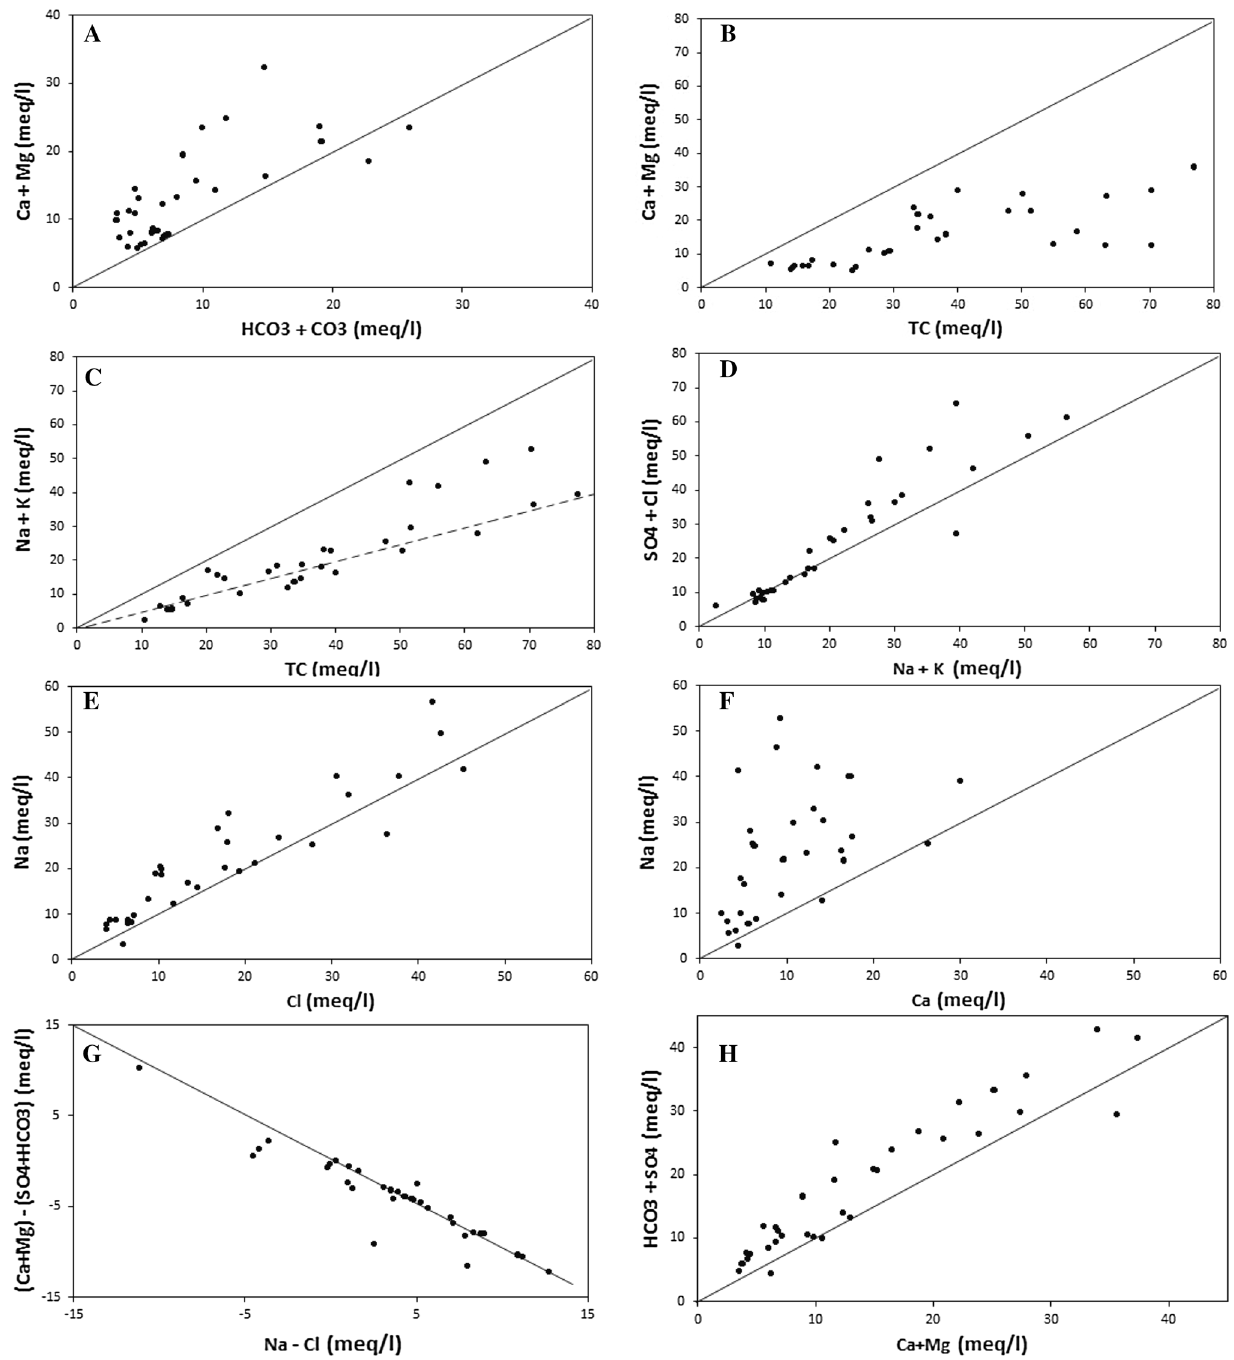
Fig. 4 Graphs of different parameters (solid and dashed lines denotes 1:1 and 1:0.5,